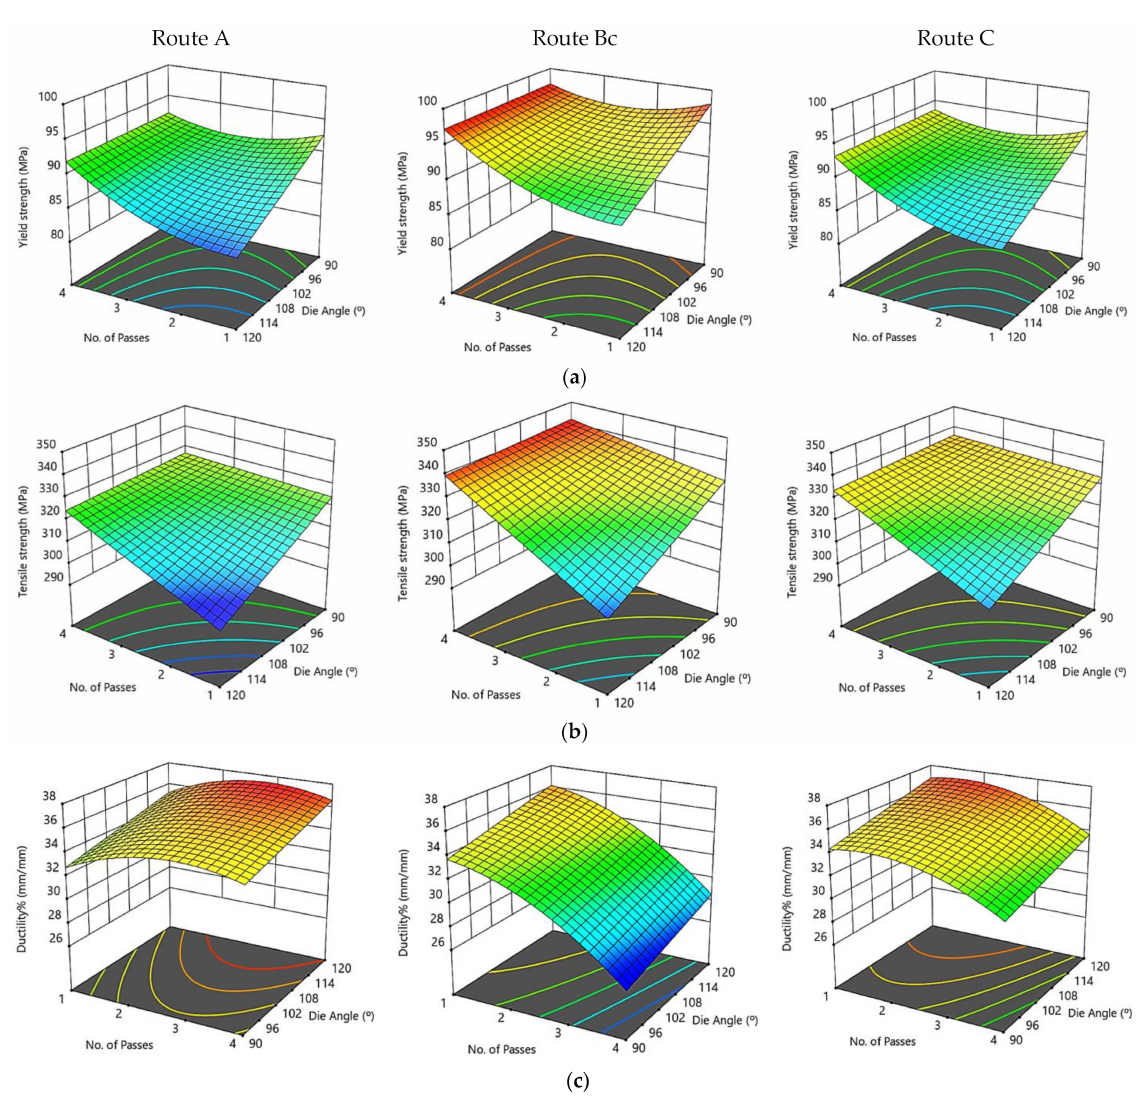
Figure 11. Three-dimensional plot of YS ( a ), TS, ( b ) and D% ( c ) with the ECAP die angle and number of passes at routes A, Bc, and